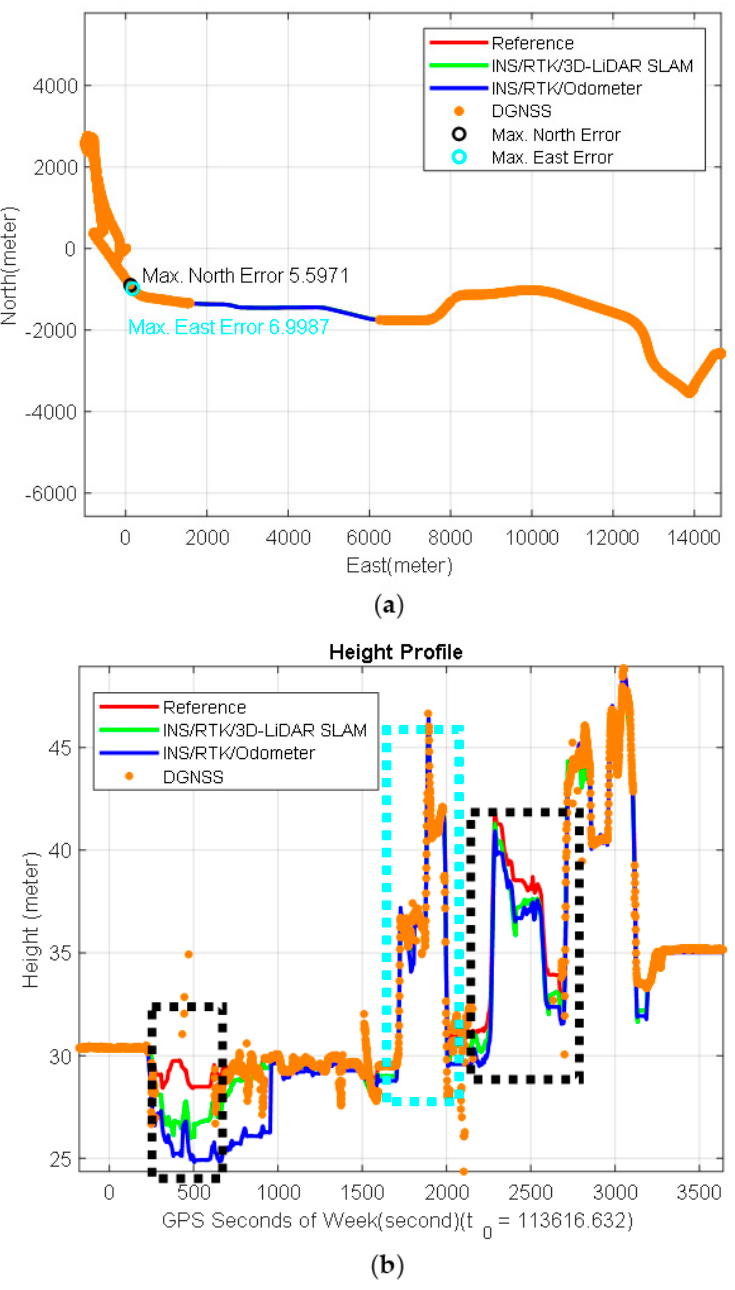
Figure 13. Scenario 2 results: ( a ) horizontal trajectory, ( b ) height